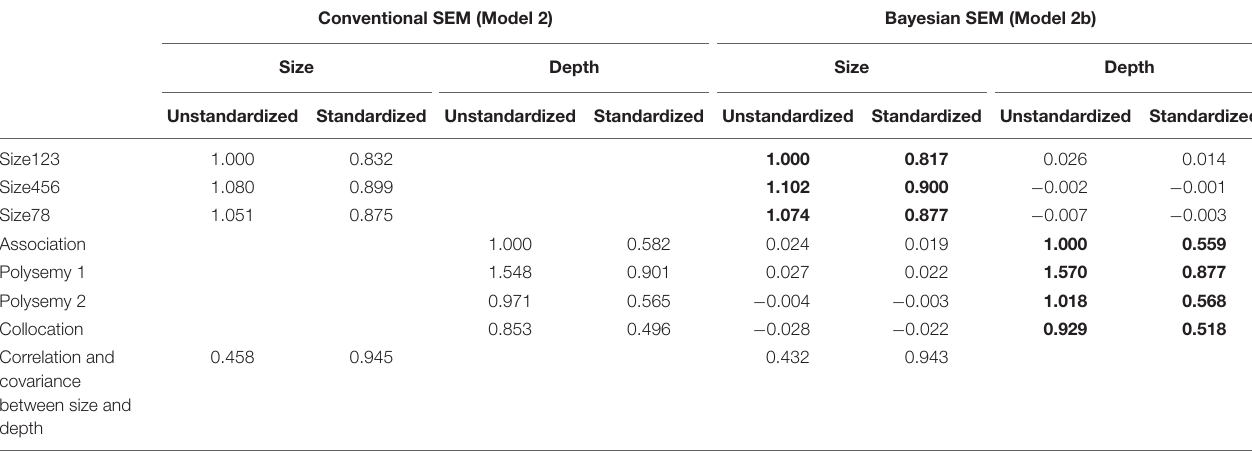
TABLE 4 | Parameter estimate of the correlated two-factor